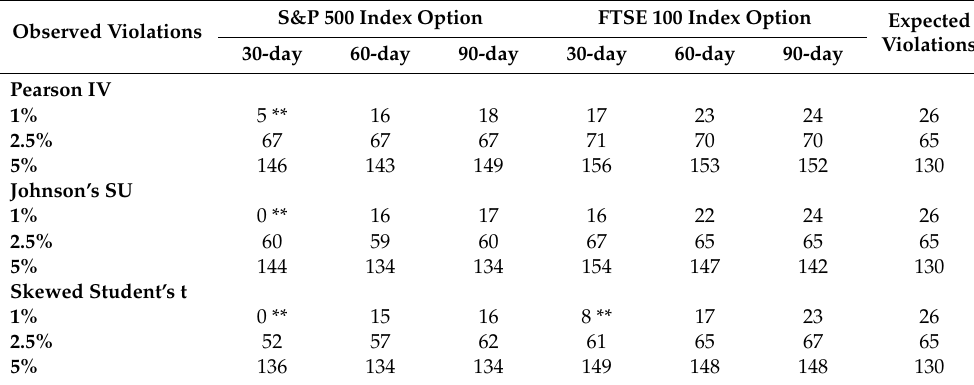
Table 2. Back-testing results for 10-day VaR.